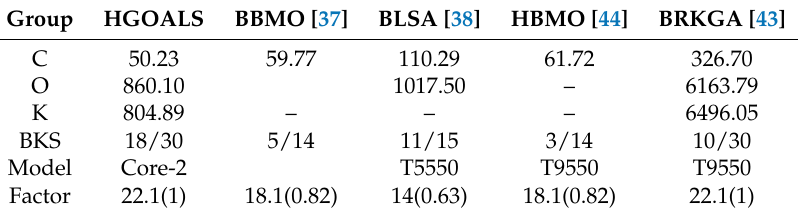
Table 11. Average CPU times comparison for the different solution approaches (minimizing traveling cost).